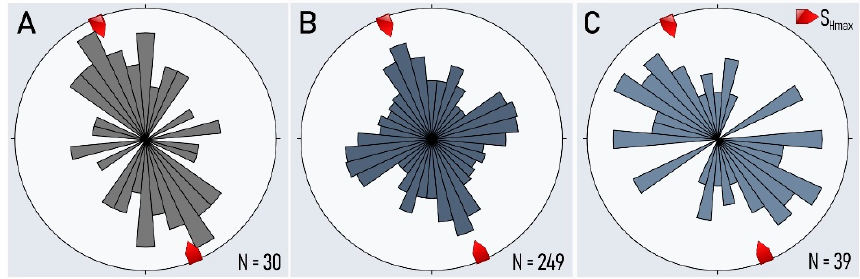
Figure 6. Rose diagram showing ( A ) the strike of clast cutting fractures at the exposure 2, ( B ) the orientation of lineaments, and ( C ) the orientation of fault traces on the Gda ń sk Pomerania area. As mentioned, all exposures of gravels bearing fractured clasts were located at line- aments parallel to numerous mapped faults, suggesting that the lineaments followed un-